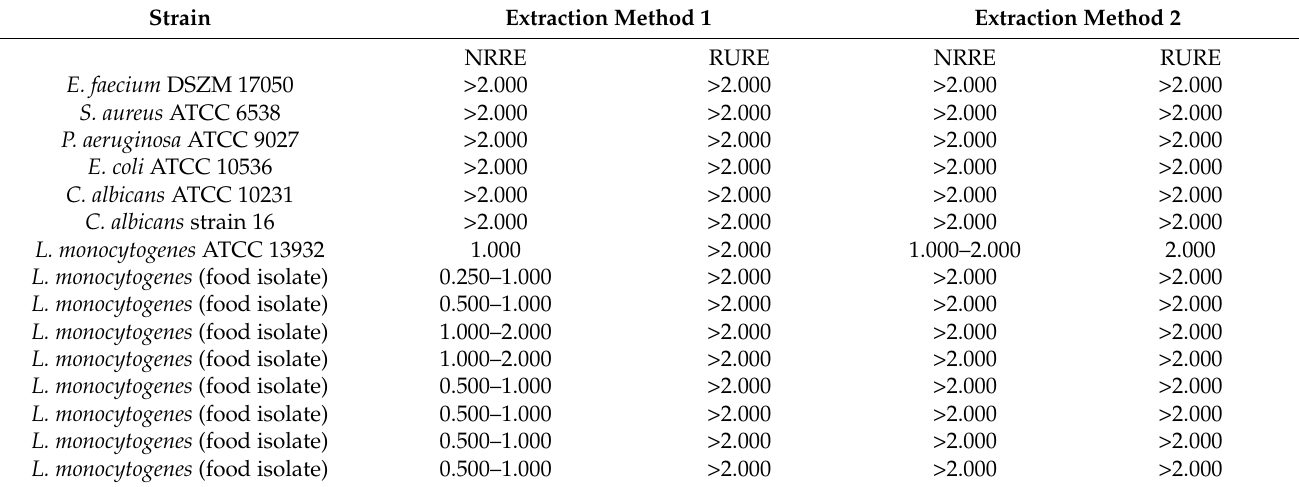
Table 3. MICs of Pistachio Extracts (expressed as mg mL − 1 ) against tested strains. NRRE: